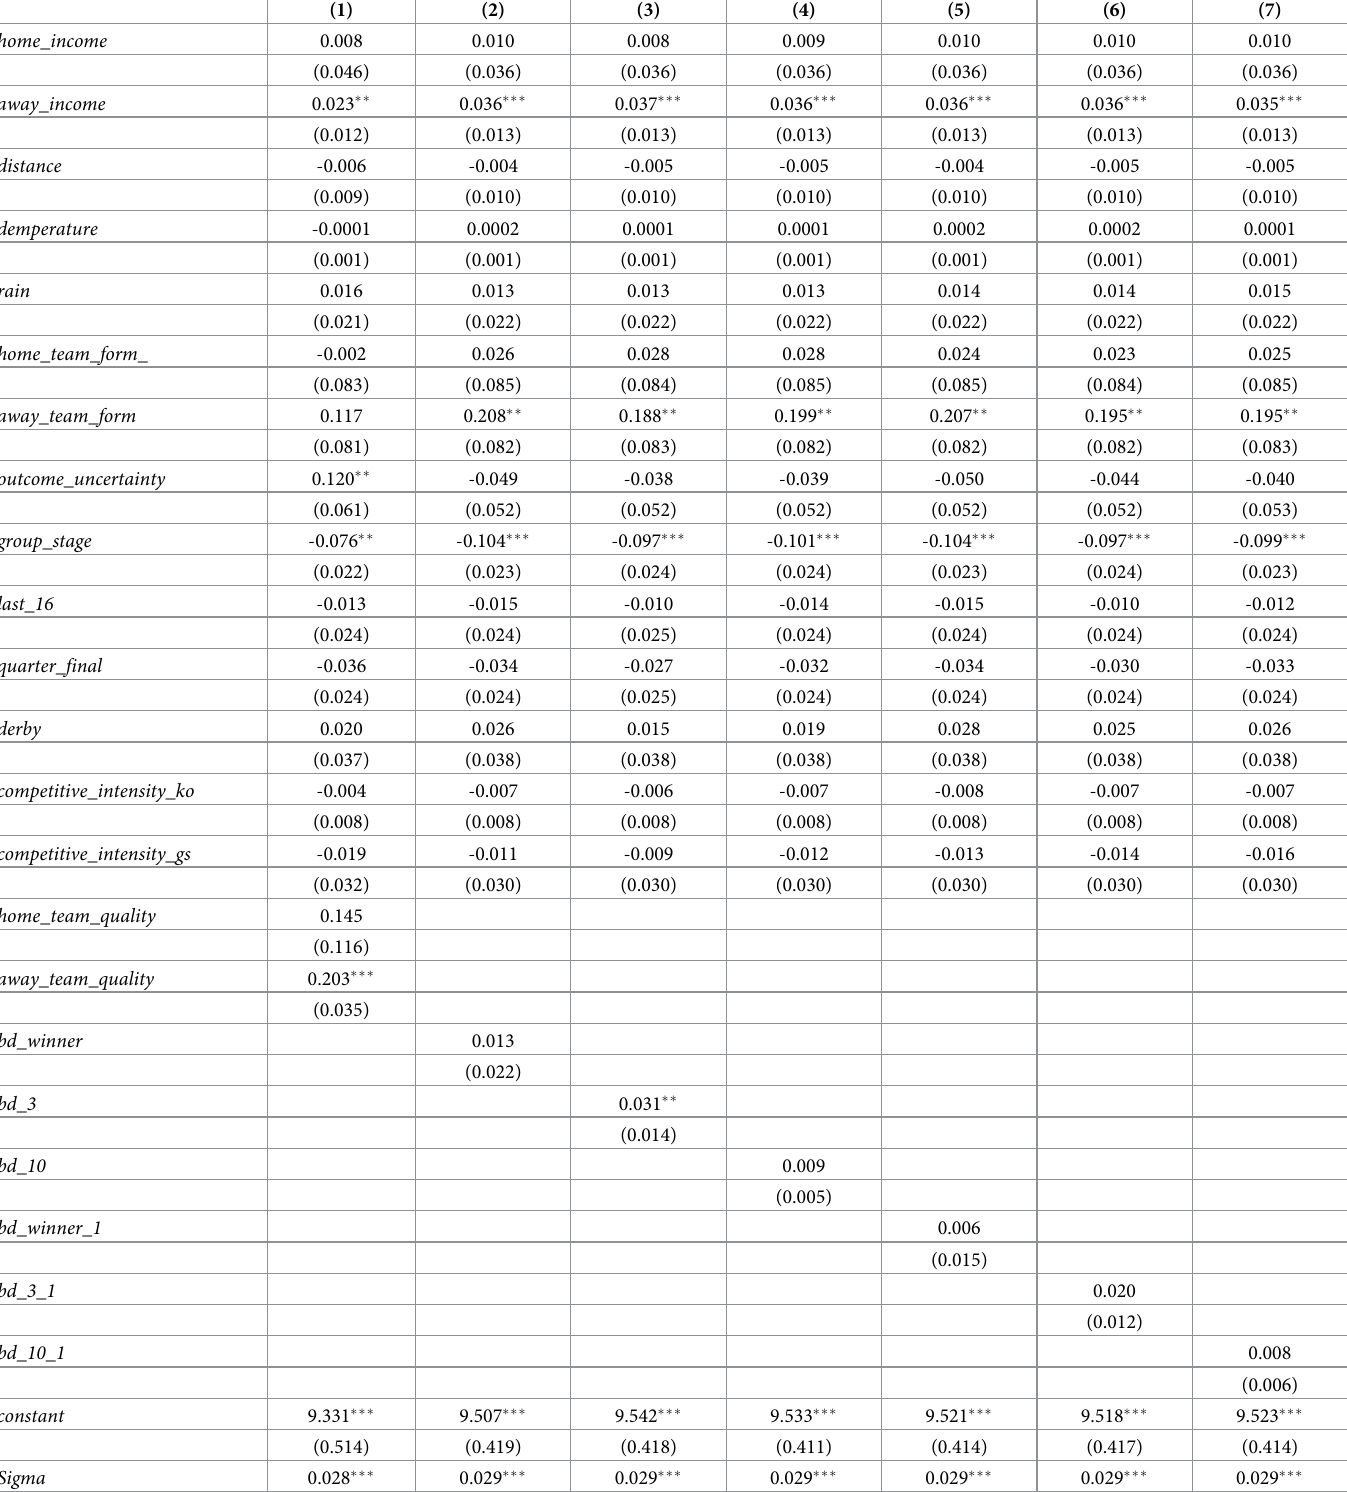
Table 3. UCL attendance in the countries hosting the top five